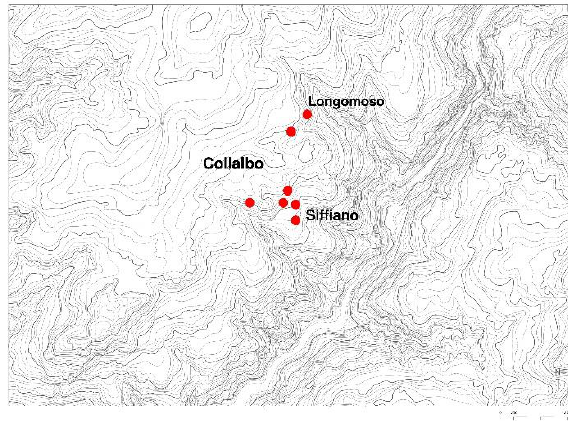
Figure 1: Orography of the Renon area with the identification of the seven farmhouses between the towns of Collalbo, Siffiano and